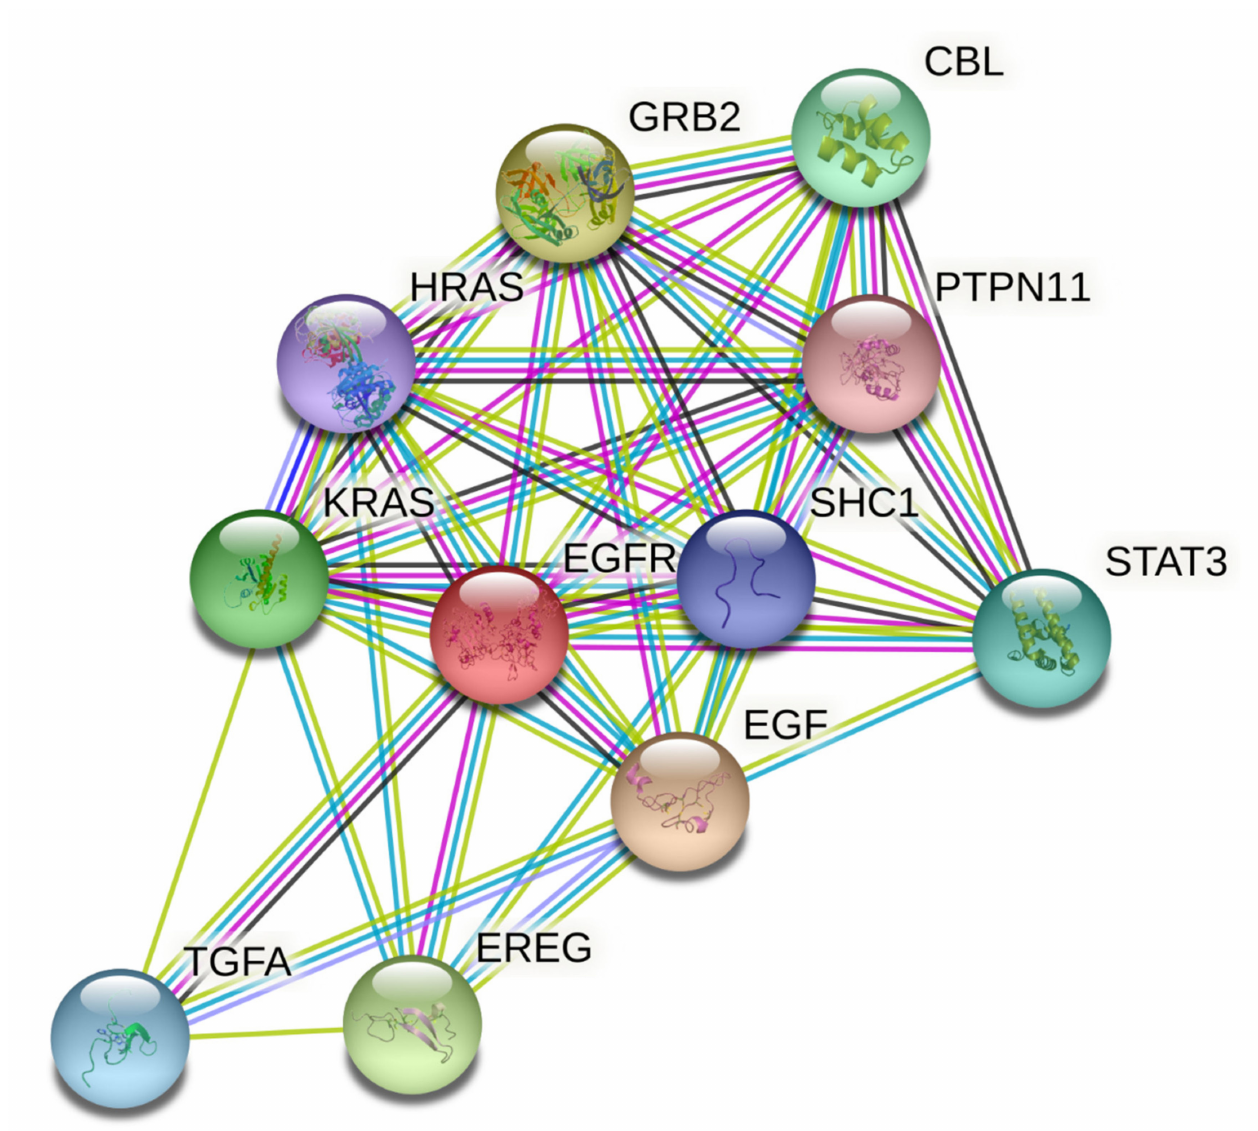
Figure 6. Protein–protein interaction network of targets related to cancer. The colored nodes represent candidate proteins, and colored lines represent protein interactions. Light green—represents text mining; Black—represents co-expression; Light blue—represents known interactions from curated databases; State blue—represents protein homology; Magenta— represents experimentally determined known interactions; Green—represents predicted interactions between neighborhood genes; Red—represents predicted interactions of gene fusion; and Blue—represents predicted interactions between co- occurred